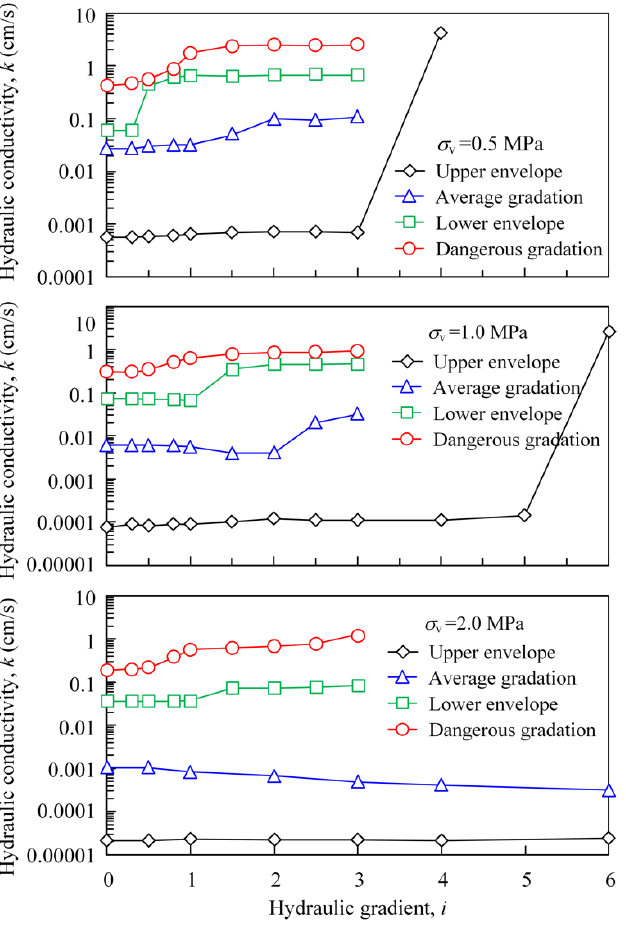
Figure 6. Hydraulic conductivity versus imposed hydraulic gradient .